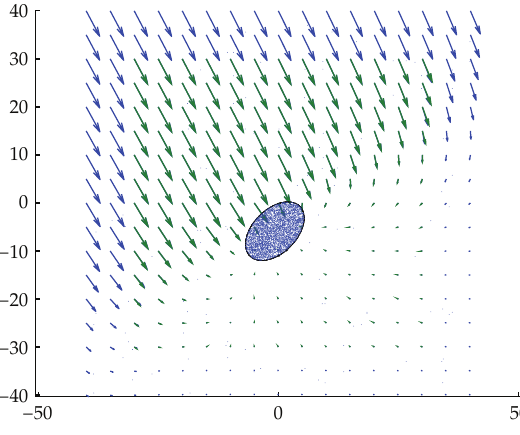
Figure 6: Gradient field of cone (cid:2) 2 (cid:3) of Example 2.1. Many starting points do not have a gradient that points directly at the feasible